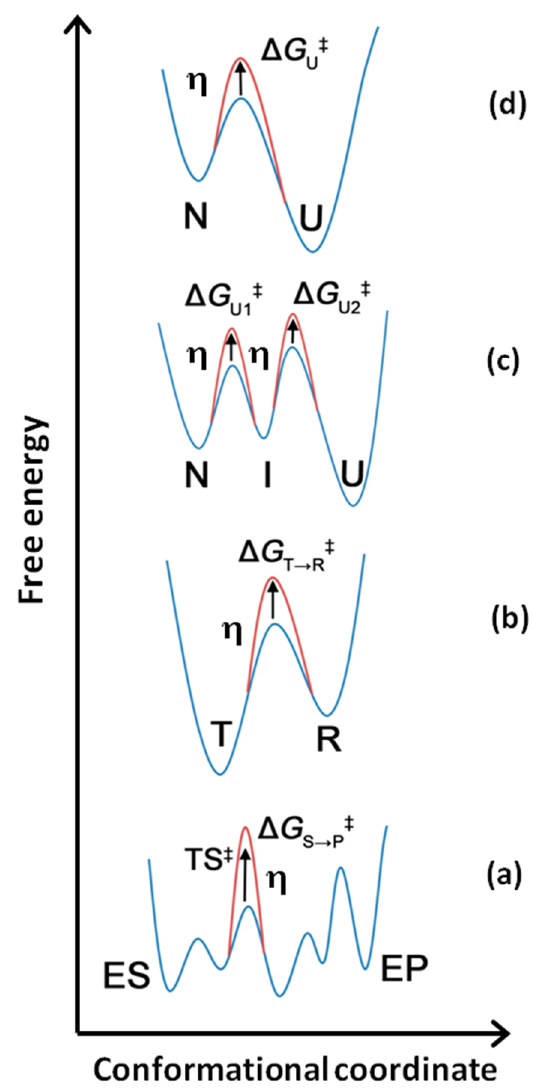
Figure 1. Energy landscape of di ff usion-dependent protein processes. High medium viscosity ( η ) increases the free energy height (red line) of the interconversion between conformational states in proteins (blue line). ( a ) Structural conformational states in enzyme catalysis, ( b ) conformational equilibrium between the T and R states in a cooperative enzyme regarding the model of Monod, Wyman, and Changeux [69,70], ( c ) three-state protein unfolding (N ↔ I ↔ U); formation of the intermediary (I) may involve the dissociation of monomers from the oligomer, ( d ) two-state protein unfolding (N ↔ U).